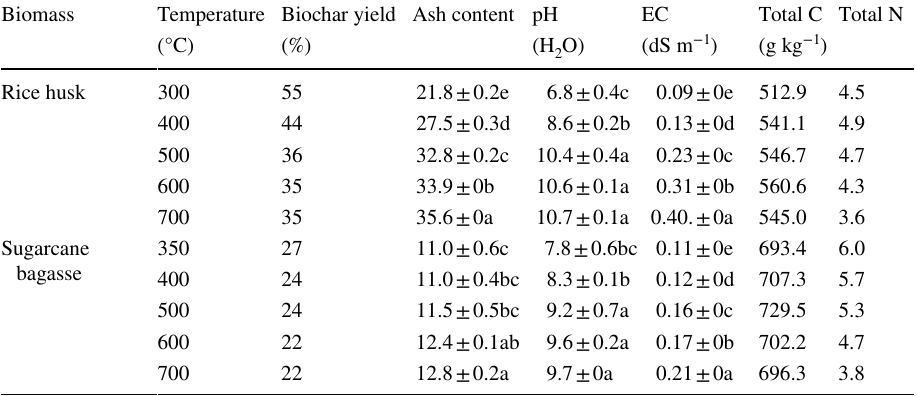
Values followed by the same letter within RHB or SBB columns were not significantly different at P < 0.05 according to Duncan’s Multiple Range Test. Values represent mean ± standard deviation of ( n